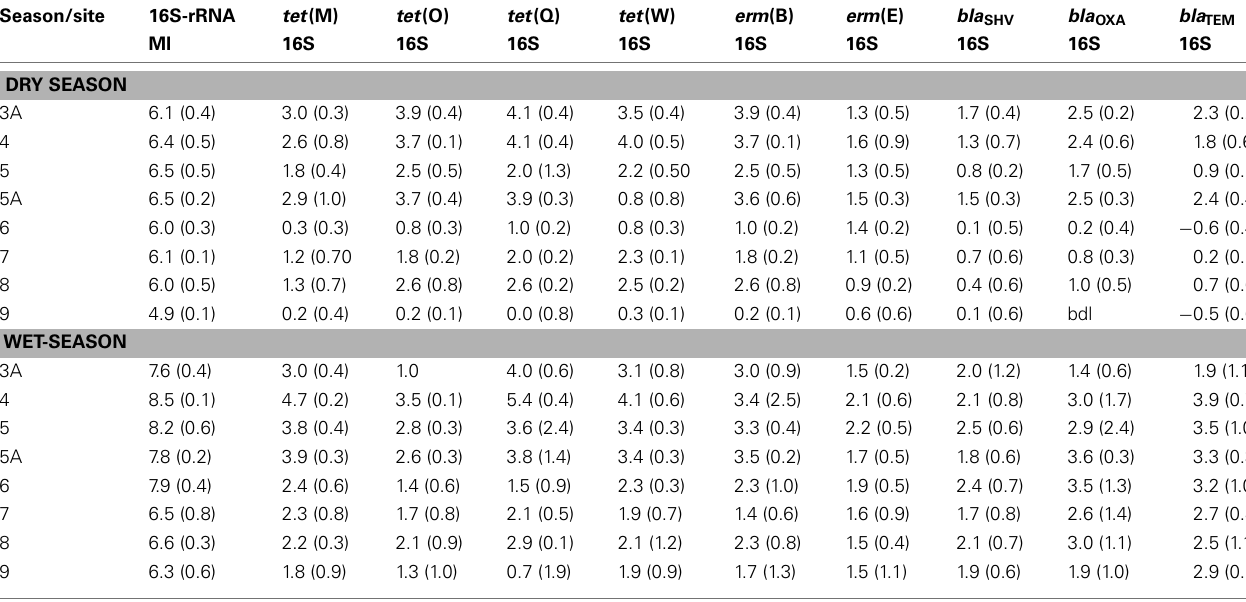
TableA4 |Total 16S-rRNA and antibiotic resistance gene abundances (per mL water) in the water column of theAlmendares